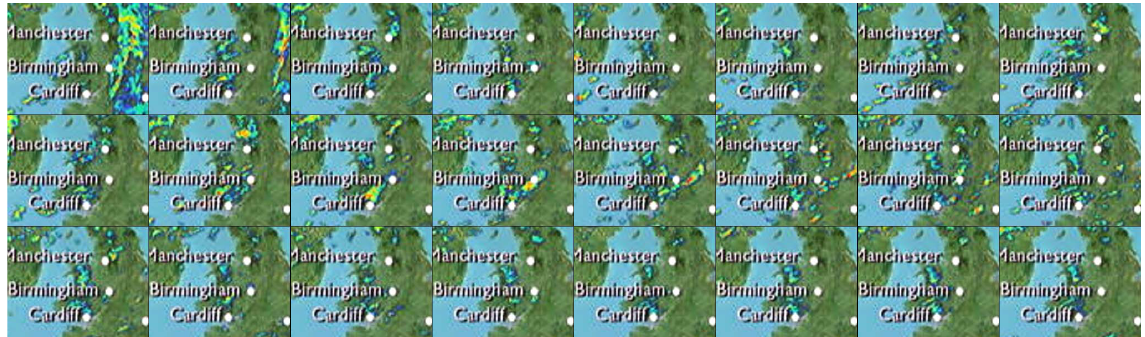
Fig. 3. Sequence of weather radar images for 1 October 2001, at 1h intervals, starting top left at 00:00 UT. Rows are 00:00–07:00 UT, 08:00–15:00 UT, 16:00–23:00 UT. Rain rate increases for blue, green, yellow, orange to red contours.